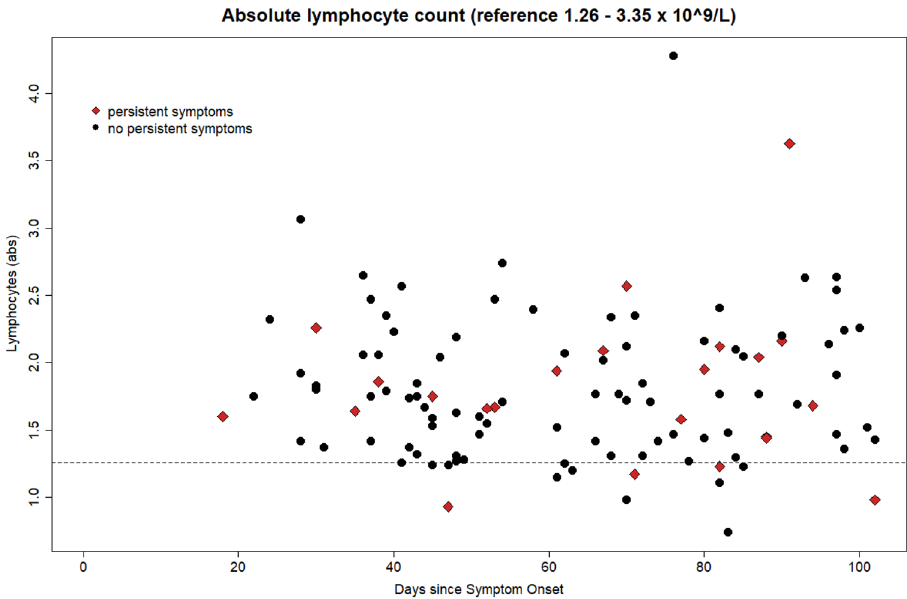
Figure 4. Absolute lymphocyte count over time. Dashed line represents lab-specific lower limit (1.26 × 10 9